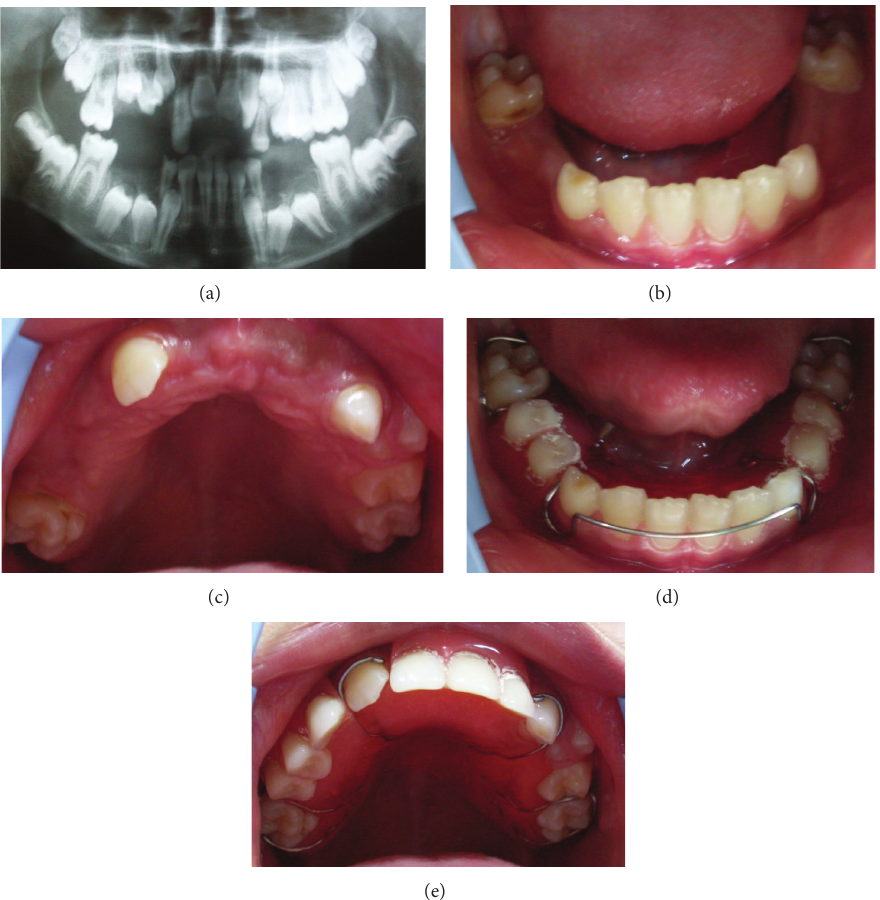
Figure 4: Intraoral and panoramic views 1 month after the extractions. (a) Postoperative panoramic radiograph. (b, c) Postoperative intraoral views of the patient. (d, e) Space maintainers were prepared for maxillary and mandibular